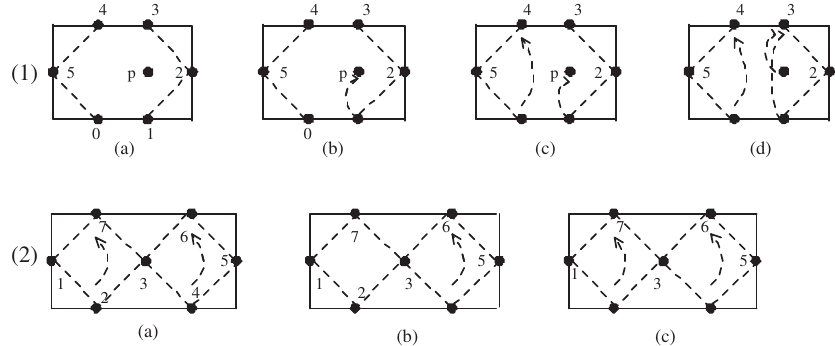
Figure 2. In these figures, the dotted arrows indicate 8-continuous mappings in the DTC ( 8 ) -setting. (1) Perfectness of F ( X ,8 ) ; (2) Perfectness of F ( C 2,4